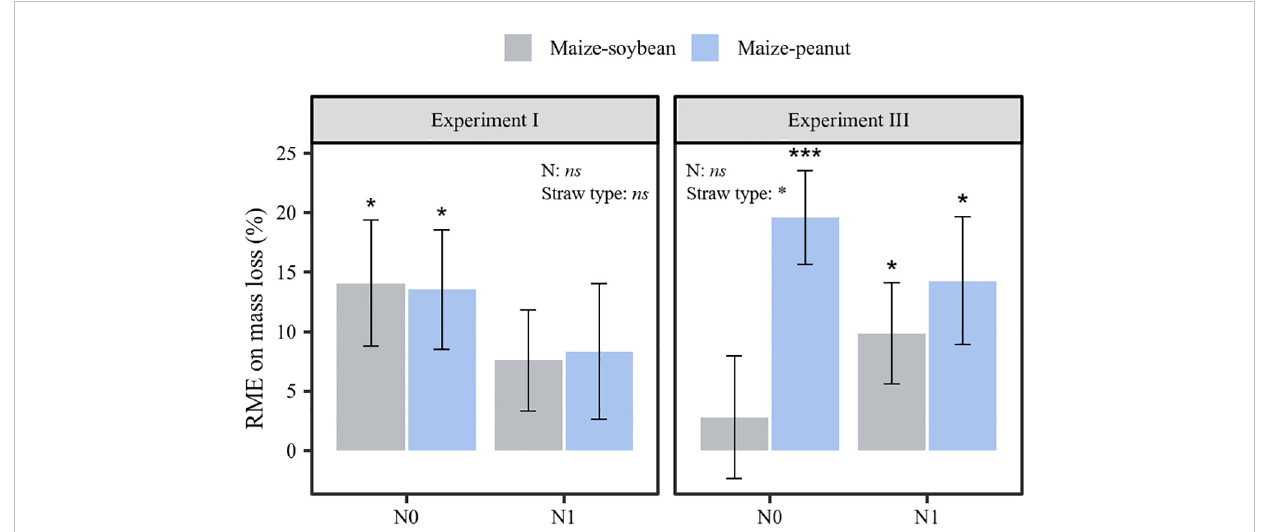
FIGURE 4 The relative mixing effects (RME) on straw mass loss in experiments I and III for maize-soybean and maize-peanut mixtures at N0 and N1 conditions. Data are mean ± SE ( n =3). Asterisks above bars show signi fi cant differences between mean value and 0 (* P < 0.05, *** P < 0.001). Statistical signi fi cance of the main effects of nitrogen application and straw type on RME was also shown (* P < 0.05, ns : not signi fi